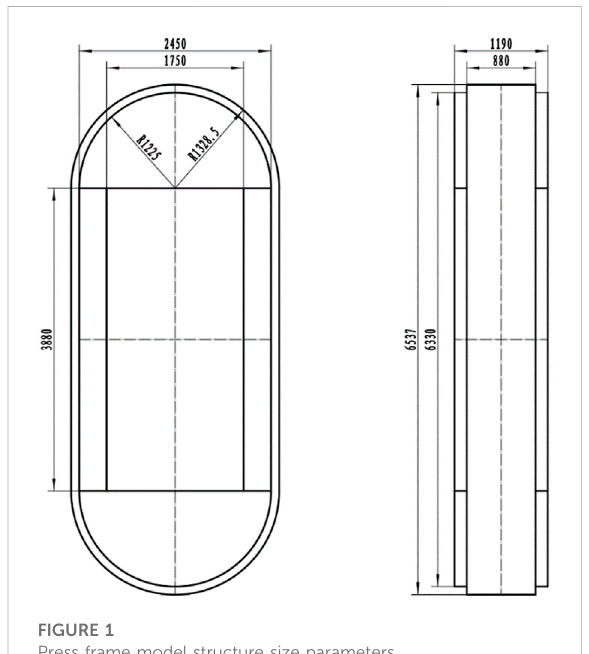
FIGURE 1 Press frame model structure size